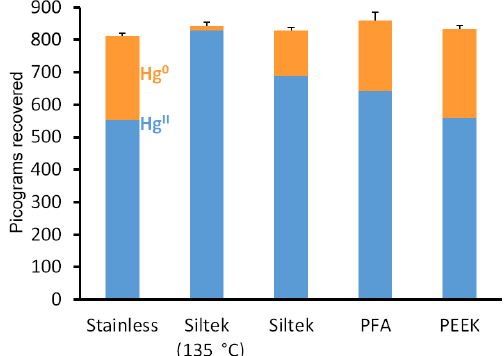
Figure 3. Picograms of Hg II and Hg 0 recovered when HgBr 2 was permeated into mercury-free air and passed through a 15cm section of 0.3cm diameter tubing constructed of the materials indicated. Tubing was kept at 110–115 ◦ C, except when indicated otherwise.